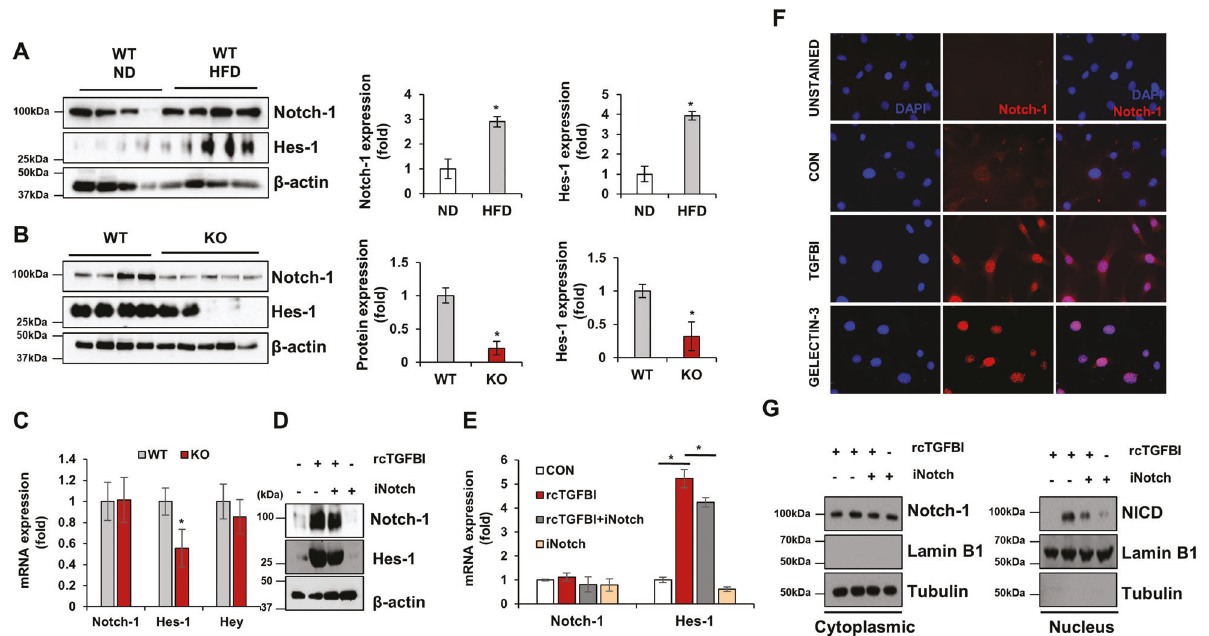
Fig. 6 TGFBI regulates the activation of Notch-1 in adipocytes. A Notch-1 and Hes-1 protein expression in iWAT obtained from ND- and HFD-fed WT mice. B, C Protein and mRNA expression of the indicated genes in iWAT obtained from the HFD-fed WT and KO mice. D-E The 3T3- L1 adipocyte line was treated with SHAM1 (Notch-1 inhibitor) in the presence or absence of recombinant TGFBI. F Localization of Notch-1 in 3T3-L1 cells treated with either recombinant TGFBI or galectin-3. G Indicated protein expression in the cytoplasm (left) and nucleus